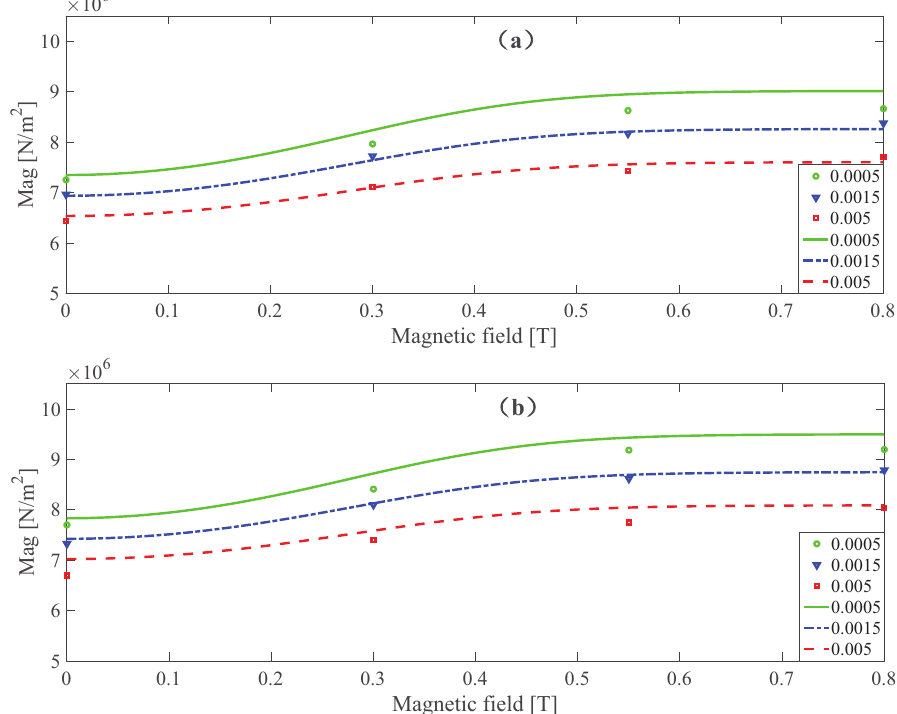
Figure 9. The magnitude of the dynamic shear modulus versus magnetic field at 400 Hz ( a ) and 700 Hz ( b ), respectively, under different strain amplitudes at 273K. Lines and symbols are the simula- tion and measurement results,